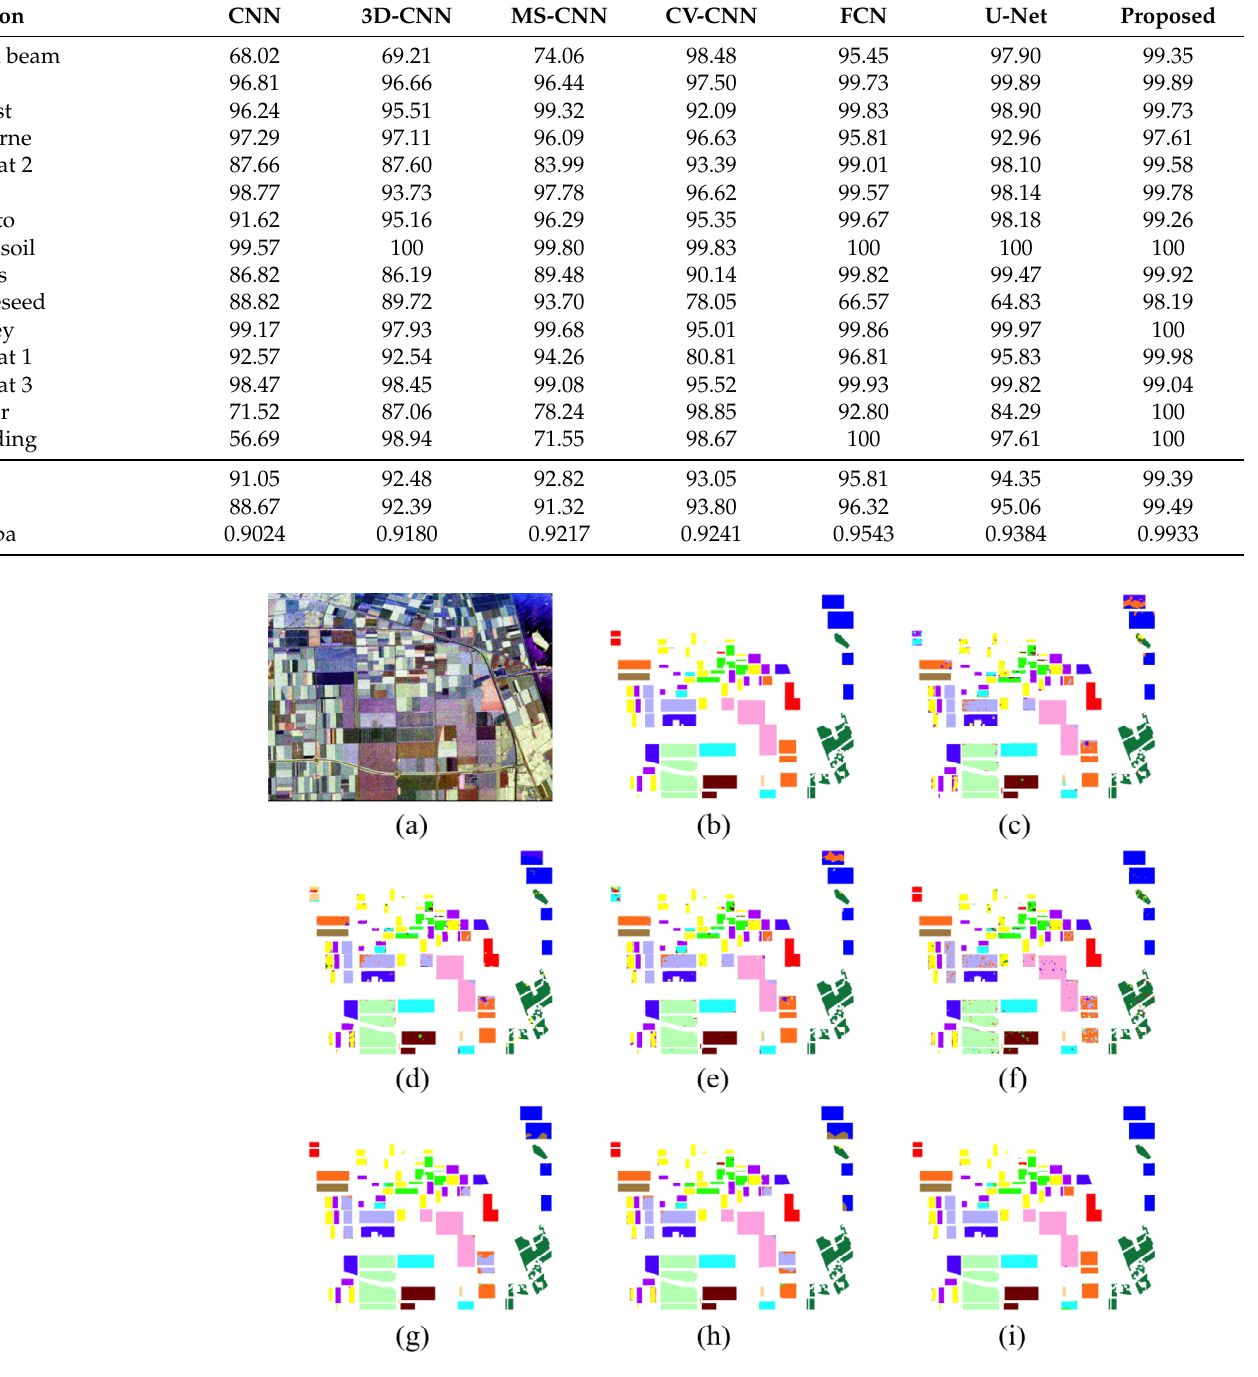
Figure 8. Results of the Flevoland-15 dataset: ( a ) pseudocolor image; ( b ) ground truth; ( c )